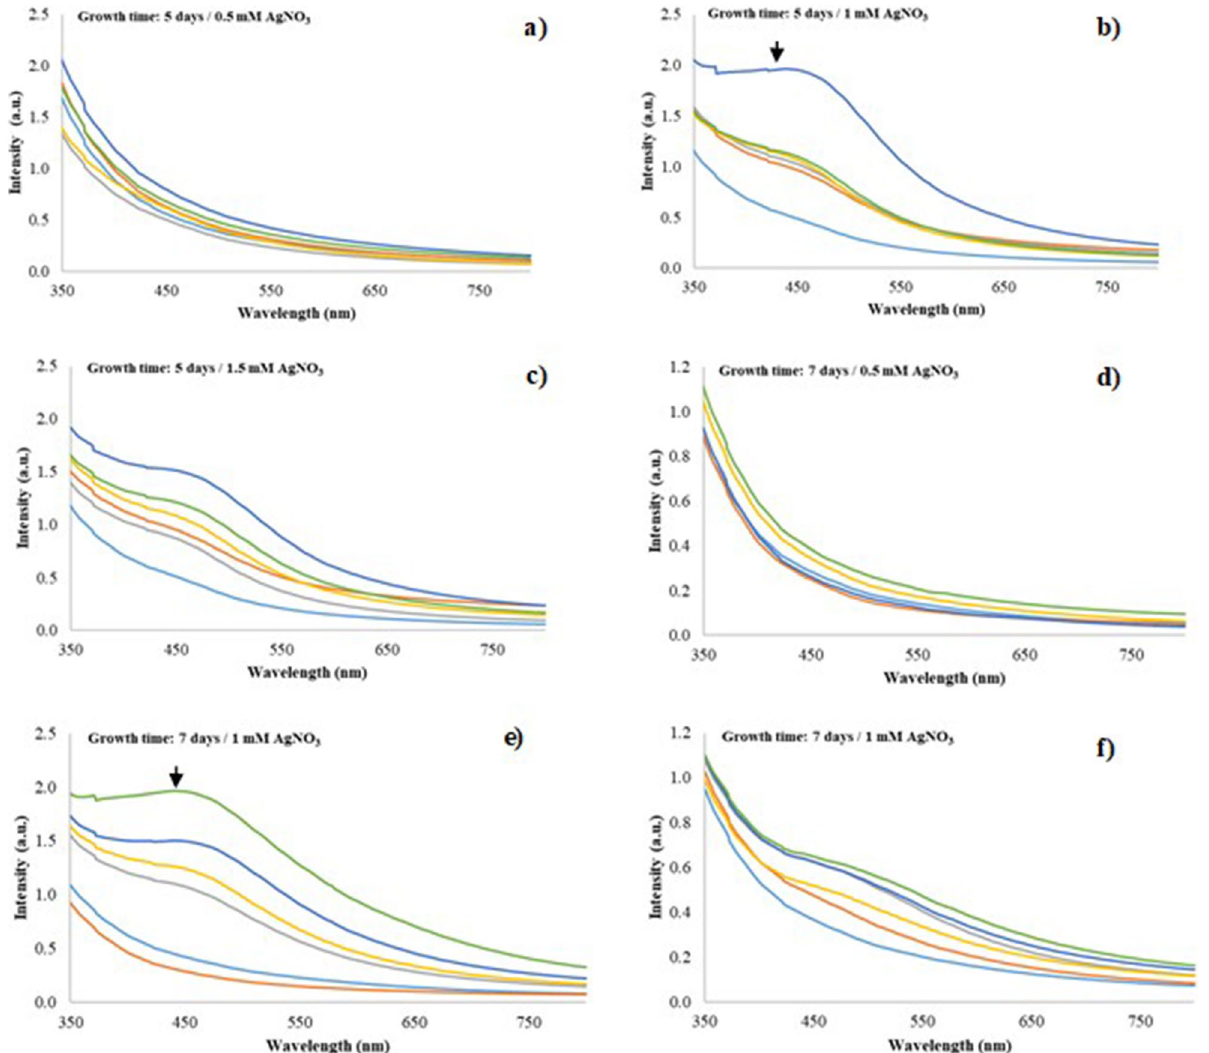
5 days/1.0 mM AgNO 3 (0.045–0.001), ( c ) Growth time: 5 days/1.5 mM AgNO 3 (0.25–0.002); ( d ) Growth time: 7 days/0.5 mM AgNO 3 (0.015–0.001); ( e ) Growth time: 7 days/1.0 mM AgNO 3 (0.020–0.001) and ( f ) Growth time: 7 days/1.5 mM AgNO 3 (0.4–0.010). Incubation time: 24 h